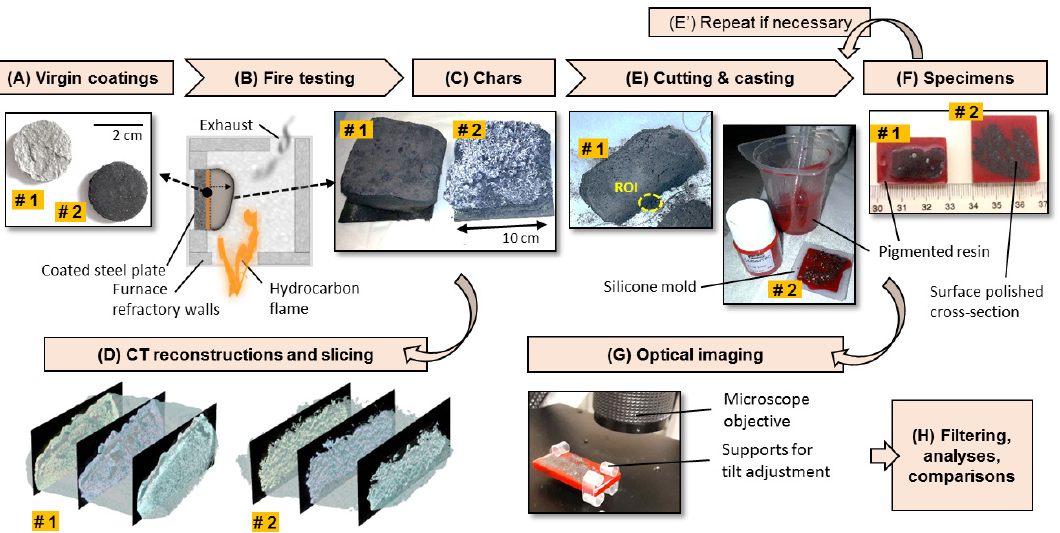
Figure 1. Overview of the workflow. Labels #1 and #2 indicate the specimen type, i.e., epoxy-based (for chemical expansion action) and silicone-based (for physical expansion action) coatings respectively. Images under their corresponding title: ( A ) Small specimens of virgin coatings. ( B ) Schematic illustration of fire testing facility [8]. ( C ) Charred specimens collected at the end of fire testing; they adhere to their underlying steel substrates. ( D ) X-ray CT 3D reconstructions of intact chars, adapted from Okyay et al. [8]. ( E ) Cutting (left) and resin casting (right). ROI is the region of interest. ( E’ ) Resin casting can be repeated to fill the void sections on the cut surface, if the specimen was not fully impregnated due to isolated pores. ( F ) Surface polished specimens; numbered ticks of the ruler are on cm scale. ( G ) Digital microscopy on resin casted